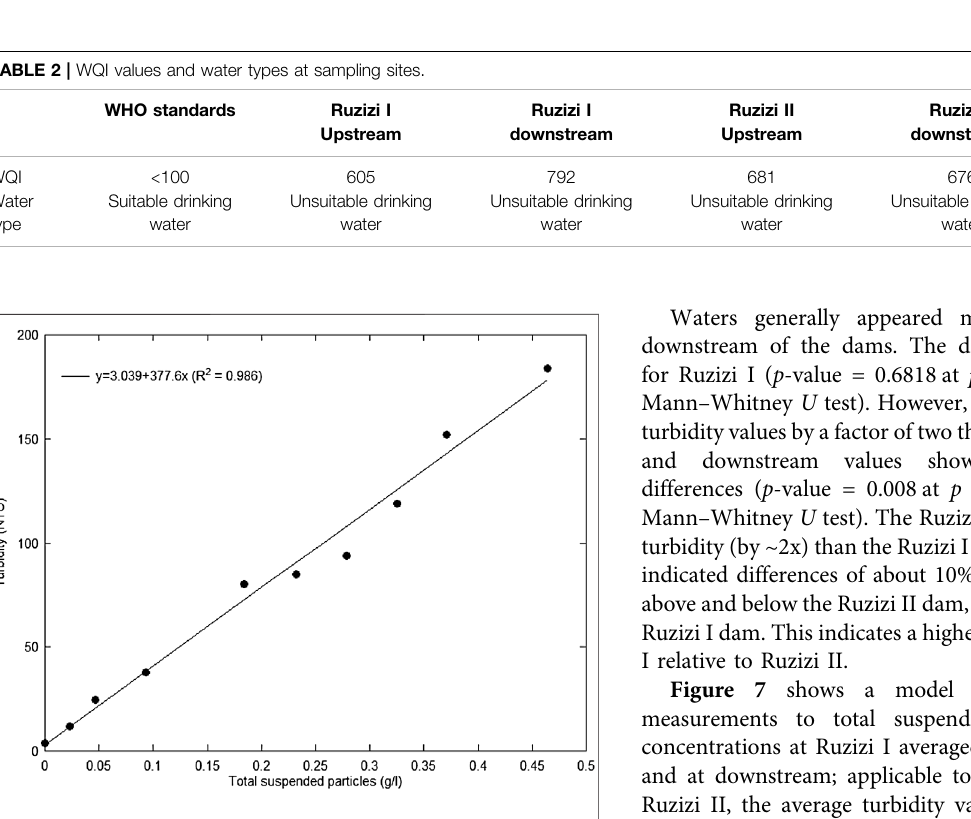
FIGURE 7 | Calibration curve between turbidity and catchment soil particle concentrations (No. of samples = 12). Soil samples (Ferralsols) were collected at ISP Bukavu in the town of Bukavu ( Figure 1A